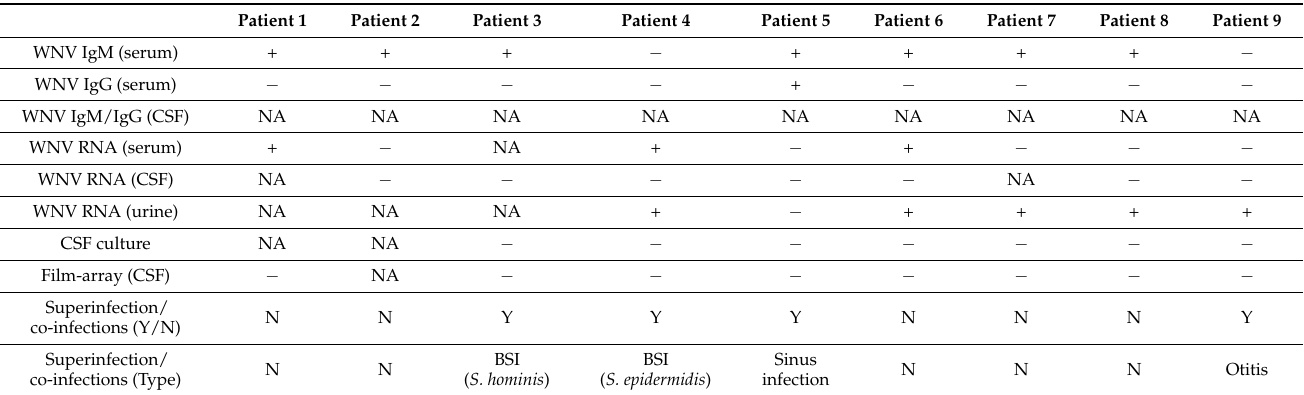
Table 3. Microbiological features of WNV infected